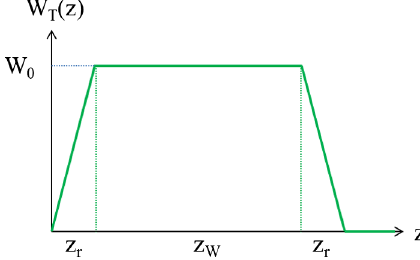
FIG. 11. The trapezoidal model for the constant wake approximation.